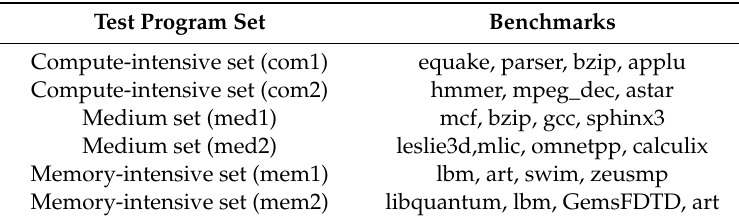
Table 3. Multiprogrammed workloads used in the experiment.